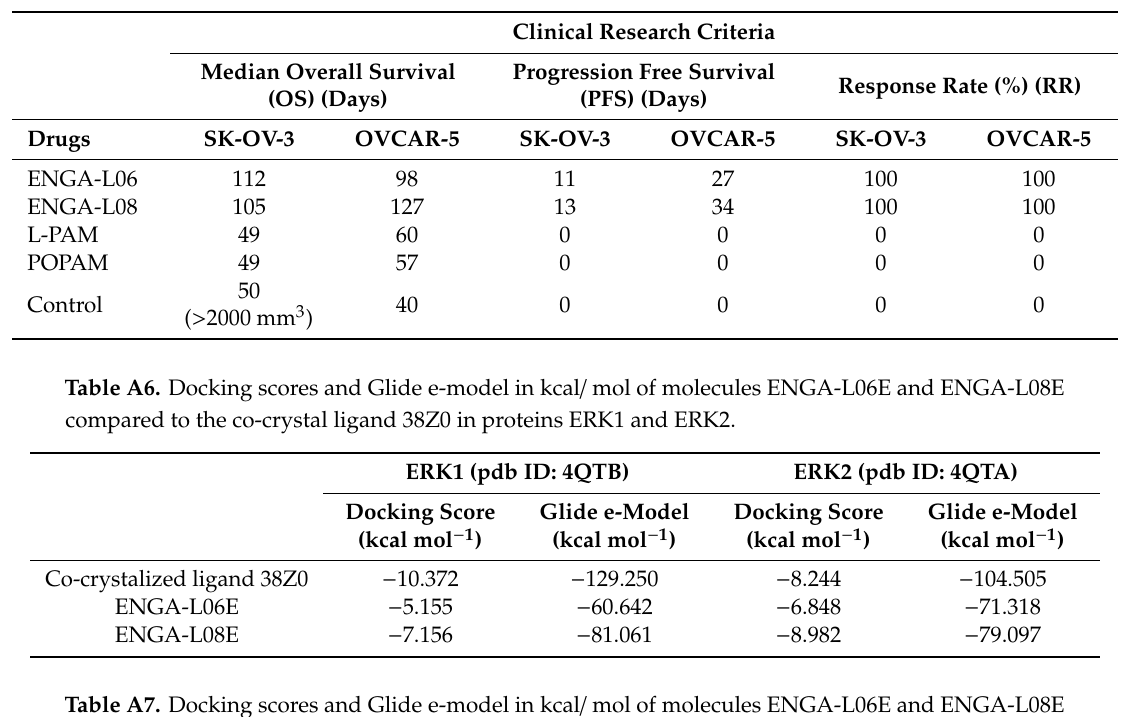
Table A5. Evaluation of the in vivo antitumor e ff ect with the clinical criteria: Median Overall Survival (OS), Progression Free Survival (PFS) and Response Rate (RR).